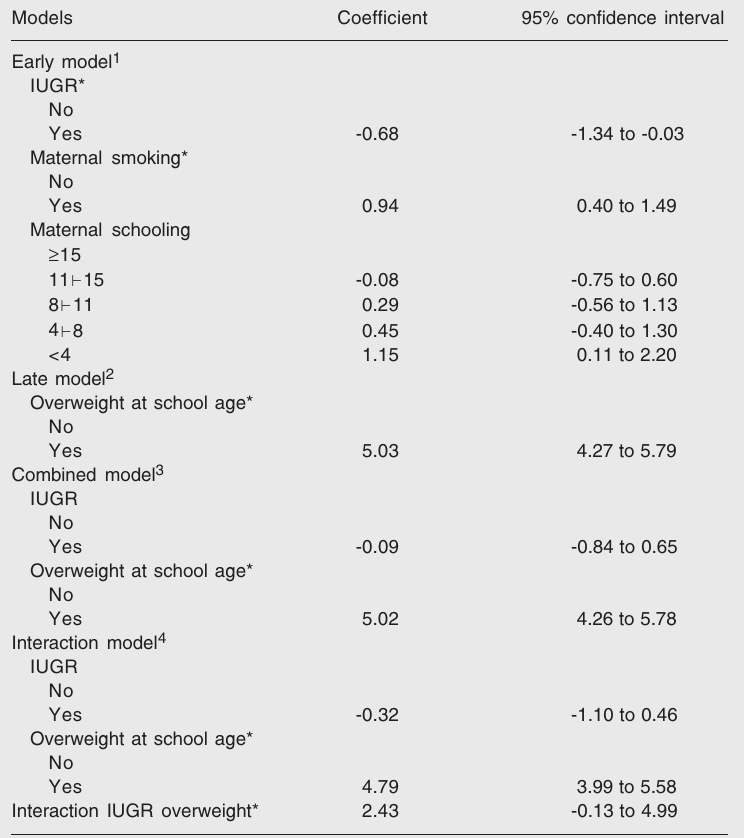
Table 3. Final multiple linear regression models for the body mass index of conscripts. Models